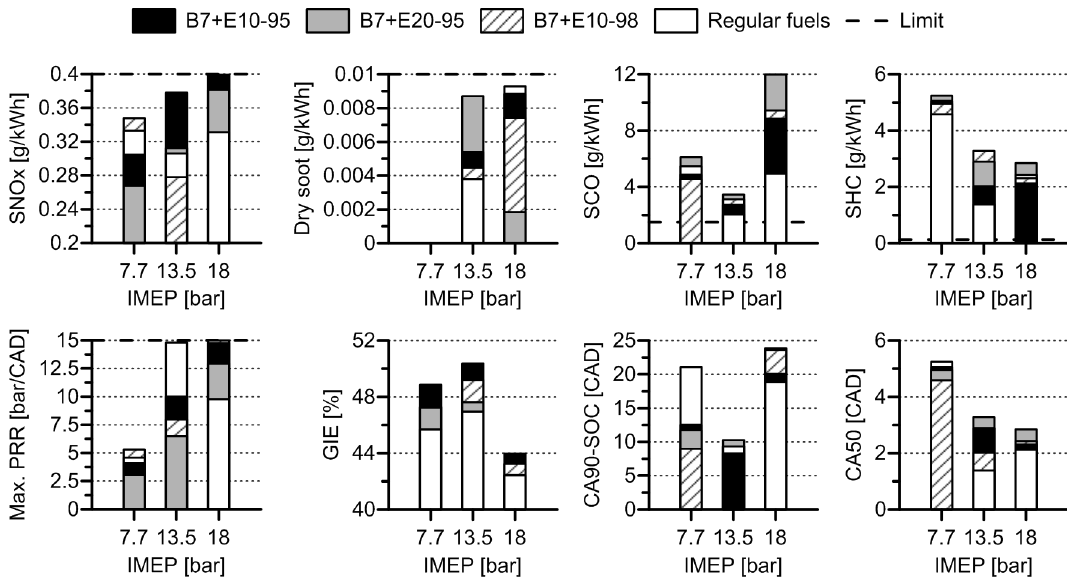
Figure 8. Best merit function results for each fuel combination at the different engine loads at 1200 rpm. Note that all bars have the same baseline value.